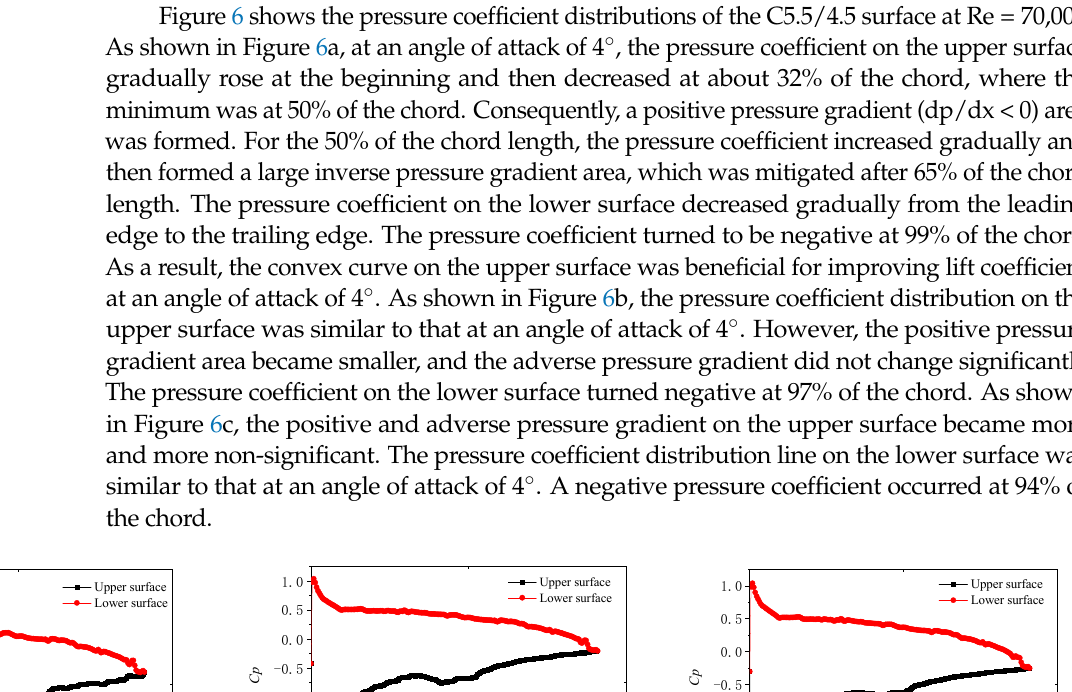
Figure 5. Aerodynamic performance of C5.5/4.5 airfoil. ( a ) Cl; ( b ) Cl/Cd; ( c ) Cl 3/2 /Cd. Figure 6 shows the pressure coefficient distributions of the C5.5/4.5 surface at Re = 70,000. As shown in Figure 6a, at an angle of attack of 4°, the pressure coefficient on the upper surface gradually rose at the beginning and then decreased at about 32% of the chord, where the minimum was at 50% of the chord. Consequently, a positive pressure